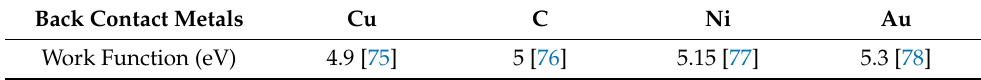
Table 2. Metal work function of back contact Table 2 . Metal work function of back contact material .